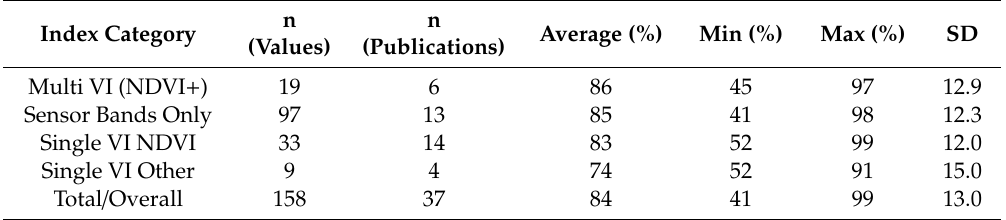
Figure 4. The frequency of indices used. Note that a number of studies used multiple indices within one publication. Hyper = Hyperspectral imagery narrow band indices, and RGB = derived from color red green blue imagery. For a list of index names see Table A1. Table 2. Summary of overall map accuracies indices taken from studies in the review that quantified overall map